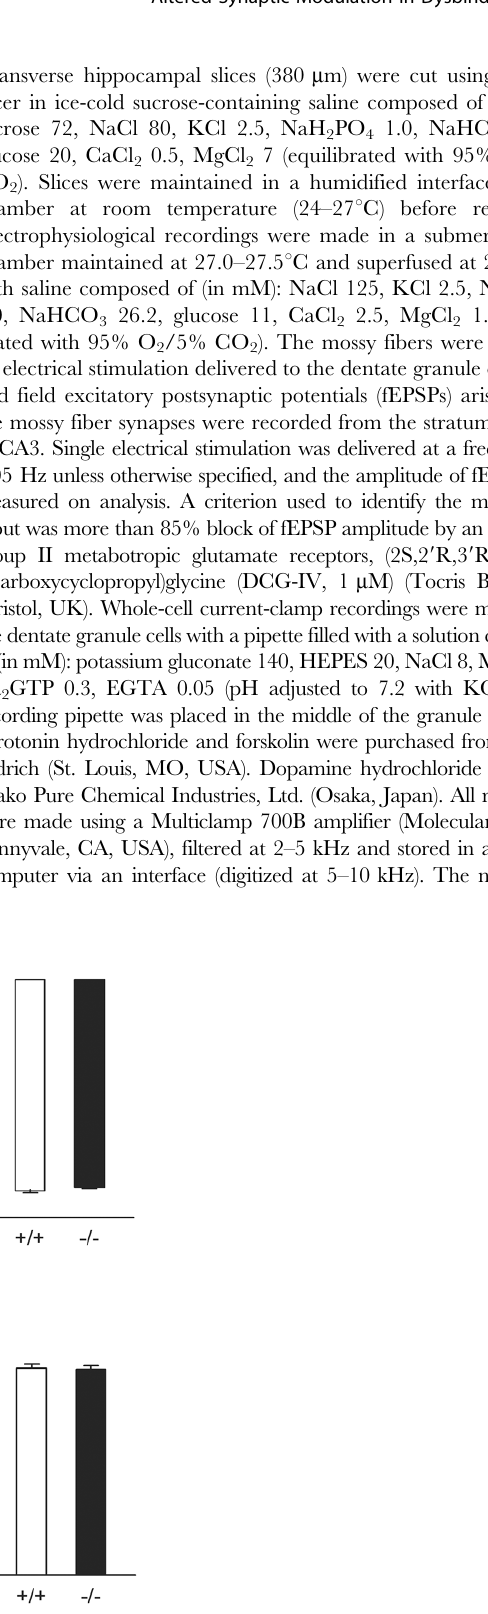
Figure 1. Passive and active somatic membrane properties of dentate granule cells. (A) Reduced input resistance in mutant mice ( + / + : 494.8 6 48.4 M V , n=12 cells; 2 / 2 : 373.6 6 33.4 M V , n=14 cells; p =0.0477).v (B) Shorter membrane time constant in mutant mice ( + / + : 33.2 6 2.2 ms; 2 / 2 : 24.9 6 1.4 ms; p =0.0109). (C–F) There was no significant difference in resting membrane potentials (C), the current intensity to evoke a single spike (D), the maximal number of spikes during sustained depolarization (E), or spike amplitude